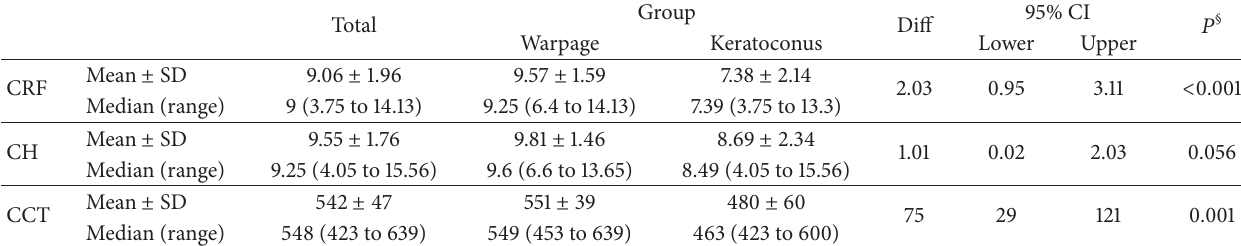
Table 2: Differences in the corneal biomechanical indexes according to the baseline diagnosis.